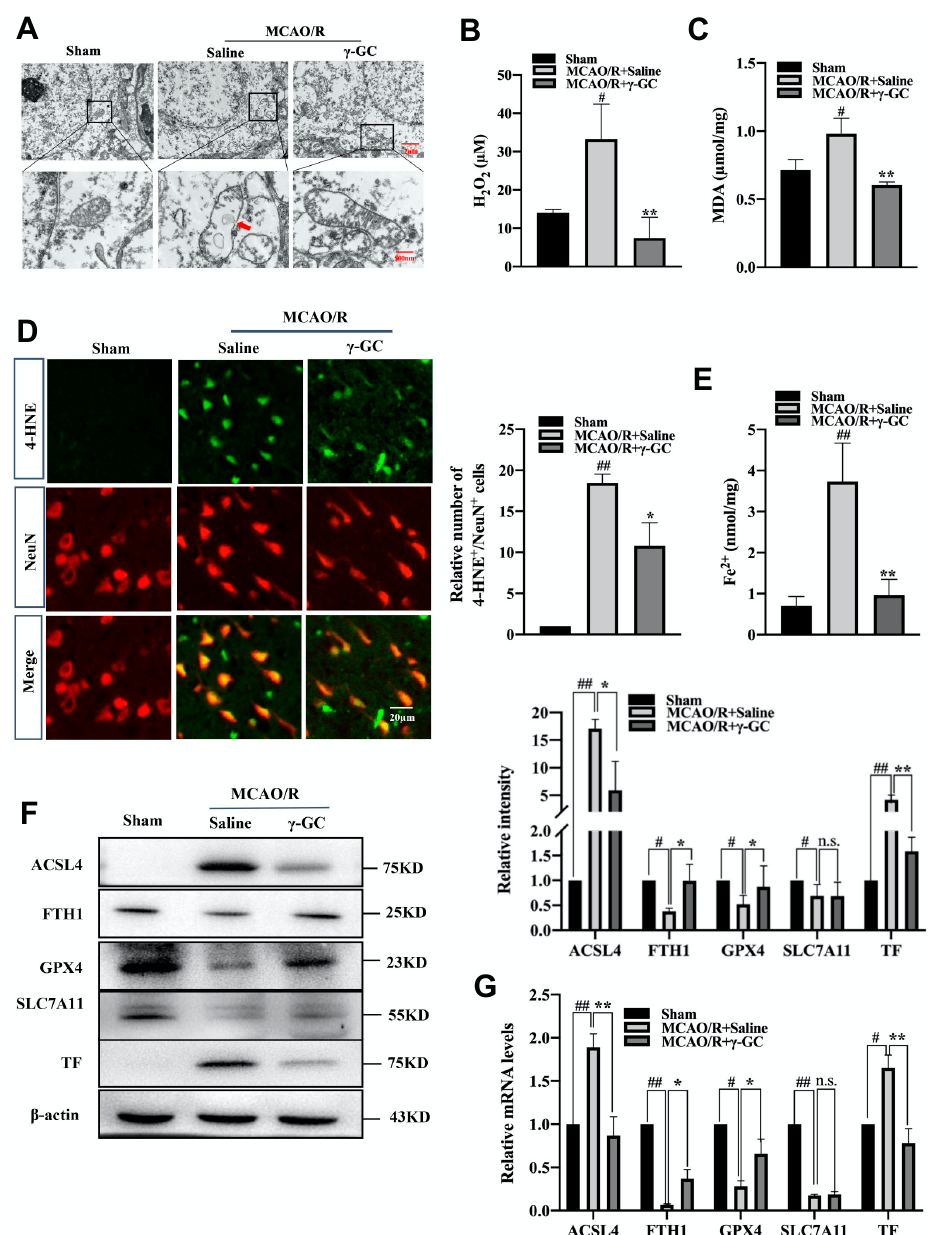
Figure 2. γ -GC inhibits MCAO/R-induced neuron ferroptosis. Rats were treated with γ -GC (688 mg/kg body weight) 1.5 h after being subjected to MCAO. Twenty-four hours after reperfusion, the following observations were performed. ( A ) The ultrastructure of neurons in the cortex was detected by transmission electron microscopy (Scale bar, 2 μ m and 500 nm). ( B , C ) H 2 O 2 and MDA contents in cortex tissues were determined using the commercial detecting kits. ( D ) Paraffin sections of rat cerebral cortex were immunofluorescence stained with 4-HNE (Green) and NeuN (Red), and the 4-HNE/NeuN double-stained cells in the cortex were quantitatively analyzed (Scale bar, 20 μ m). ( E ) Fe 2+ content in cortex tissue was tested using an iron assay kit. ( F , G ) The protein and mRNA levels of the indicated protein in cortex tissues were detected by immunoblotting and qRT-PCR assay. Data are mean ± SD (n = 3, 3 rats/group). # p < 0.05 and ## p < 0.01 versus Sham group; * p < 0.05 and ** p < 0.01 versus MCAO/R + saline group.